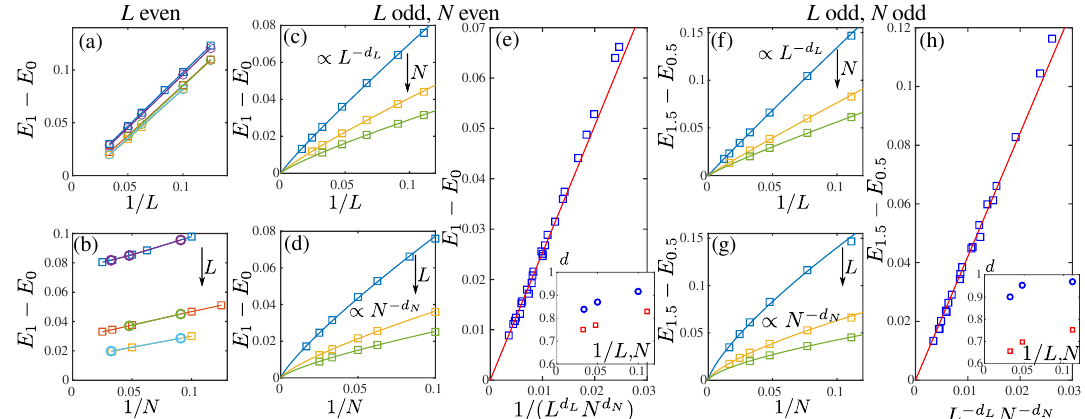
Figure 10: (Color online) Finite-size scaling of energy gaps to the lowest magnetic = 1. Finite size scaling is shown separately as a function of 1 / L excitation at J bb in (a),(c),(f) and as a function of 1 / N in (b),(d),(g). In (a)-(b) we show results for L -even and N either even (circles) or odd (diamonds). Panels (c)-(e) show results for L -odd and N -even, while panels (f)-(h) are for both N , L -odd. The lines in panels (c),(f) are results of a fit of the form ∝ L − d L , and in panels (d),(g) of the form ∝ N − d N . Panels (e) and (h) show the data collapse for the best available pair of ( d , d ). The values of d are summarized in the insets of panels (e) and (h). The N L N , L different colors on panels (a)-(d),(f)-(g) correspond to different widths / lengths of a comb.